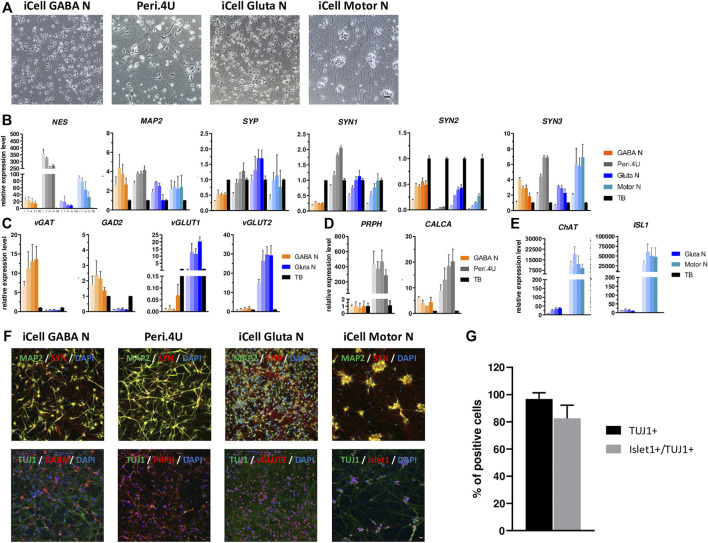
Characterization of multiple neuronal models derived from hiPSC. (A) Phase contrast images taken with a 20X objective at day 15 after thawing. Scale bar: 25 μm. (B–E) Time-course gene expression analysis of neuronal markers (B) and phenotypic markers (C,E) for the four models. Expression is normalized to GAPDH and to a control cDNA (human total brain: TB). For every model, each shade bar represents a different time point: 1 day, 7 days, 14 days and 28 days after thawing; 1 day being the lighter shade. (F) Immunolabelings at day 15 after thawing of markers for neurons (TUJ1 or MAP2), synapses (SYN), GABAergic neurons (GABA), peripheric neurons (PRPH), glutamatergic neurons (vGlut2) and motor neurons (Islet1). Nuclei are stained in blue (DAPI). Scale bar: 25 μm. (G) % of islet1+ cells amongst total cells and amongst neurons (TUJ1+).